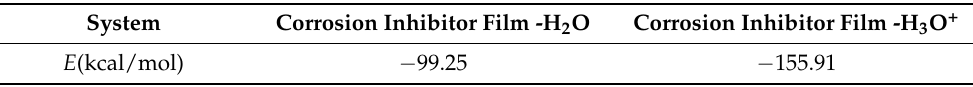
Table 5. Interaction energy of corrosion medium particles and corrosion inhibitor